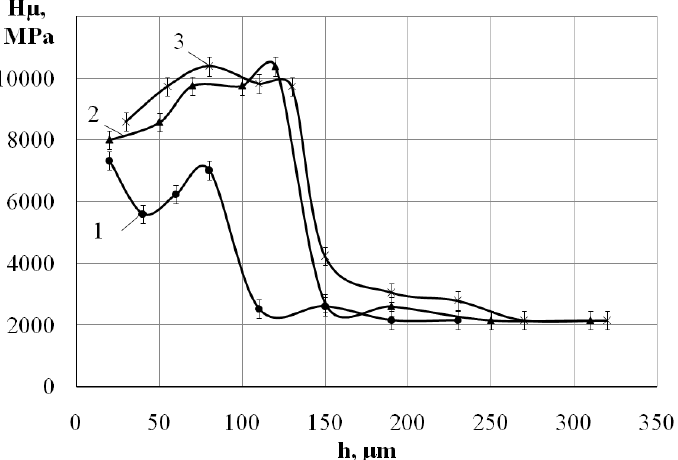
Figure 5. The distribution of the micro hardness over the depth of the nitrocarburized layer beginning from the surface of the steel C40 specimen after the ESA process by aluminum electrode-tool at W p = 3.4 J, applying a nitrogen-containing paste to the surface being processed, and alloying the obtained surface by the graphite electrode-tool at the discharge energy (W p ): 1— W p = 0.13; 2— W p = 0.52; and 3— W p = 3.40